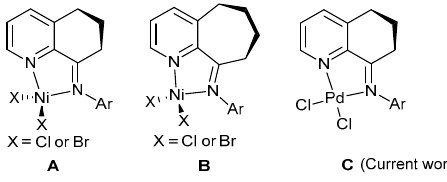
Figure 1. Geometry-constrained iminopyridylmetal halide complexes.